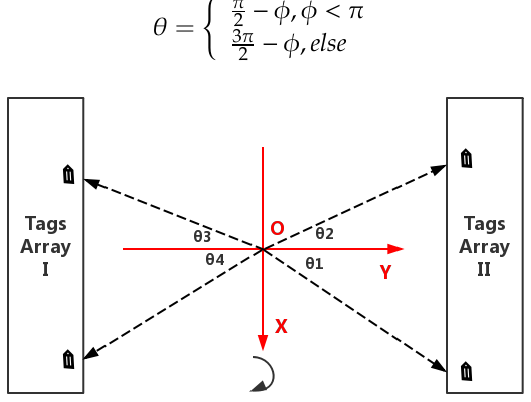
Figure 12. Relative incident angle analysis.